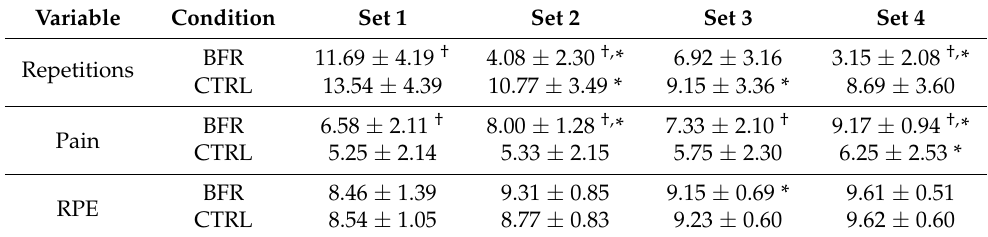
Table 2. Repetition, RPE, and Pain.